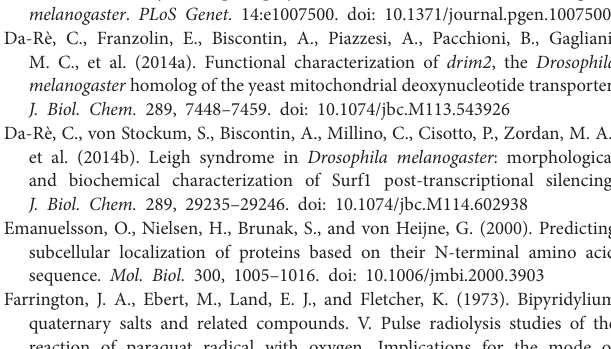
SUPPLEMENTARY FIGURE S1 | (A) dCOA8 mRNA levels, expressed as relative quantity of template in the sample (RQ), in ubiquitous (act5C-Gal4>UAS- CG14806-IR) and pan-neuronal (elav-Gal4>UAS-CG14806-IR) knockdown flies with respect to parental controls (UAS-CG14806-IR>+, act5C-Gal4>+, and elav- Gal4>+). Data plotted are mean ± S.D. ( n = 3, Student’s t test * p ≤ 0.05, ** p ≤ 0.01, *** p ≤ 0.001, **** p ≤ 0.0001). (B) Lifespan of ubiquitous male (left) and female (right) KD flies in standard food at 23 ° C. Statistical significance was assessed with log-rank (Mantel-Cox) and Gehan-Breslow-Wilcoxon tests (non-